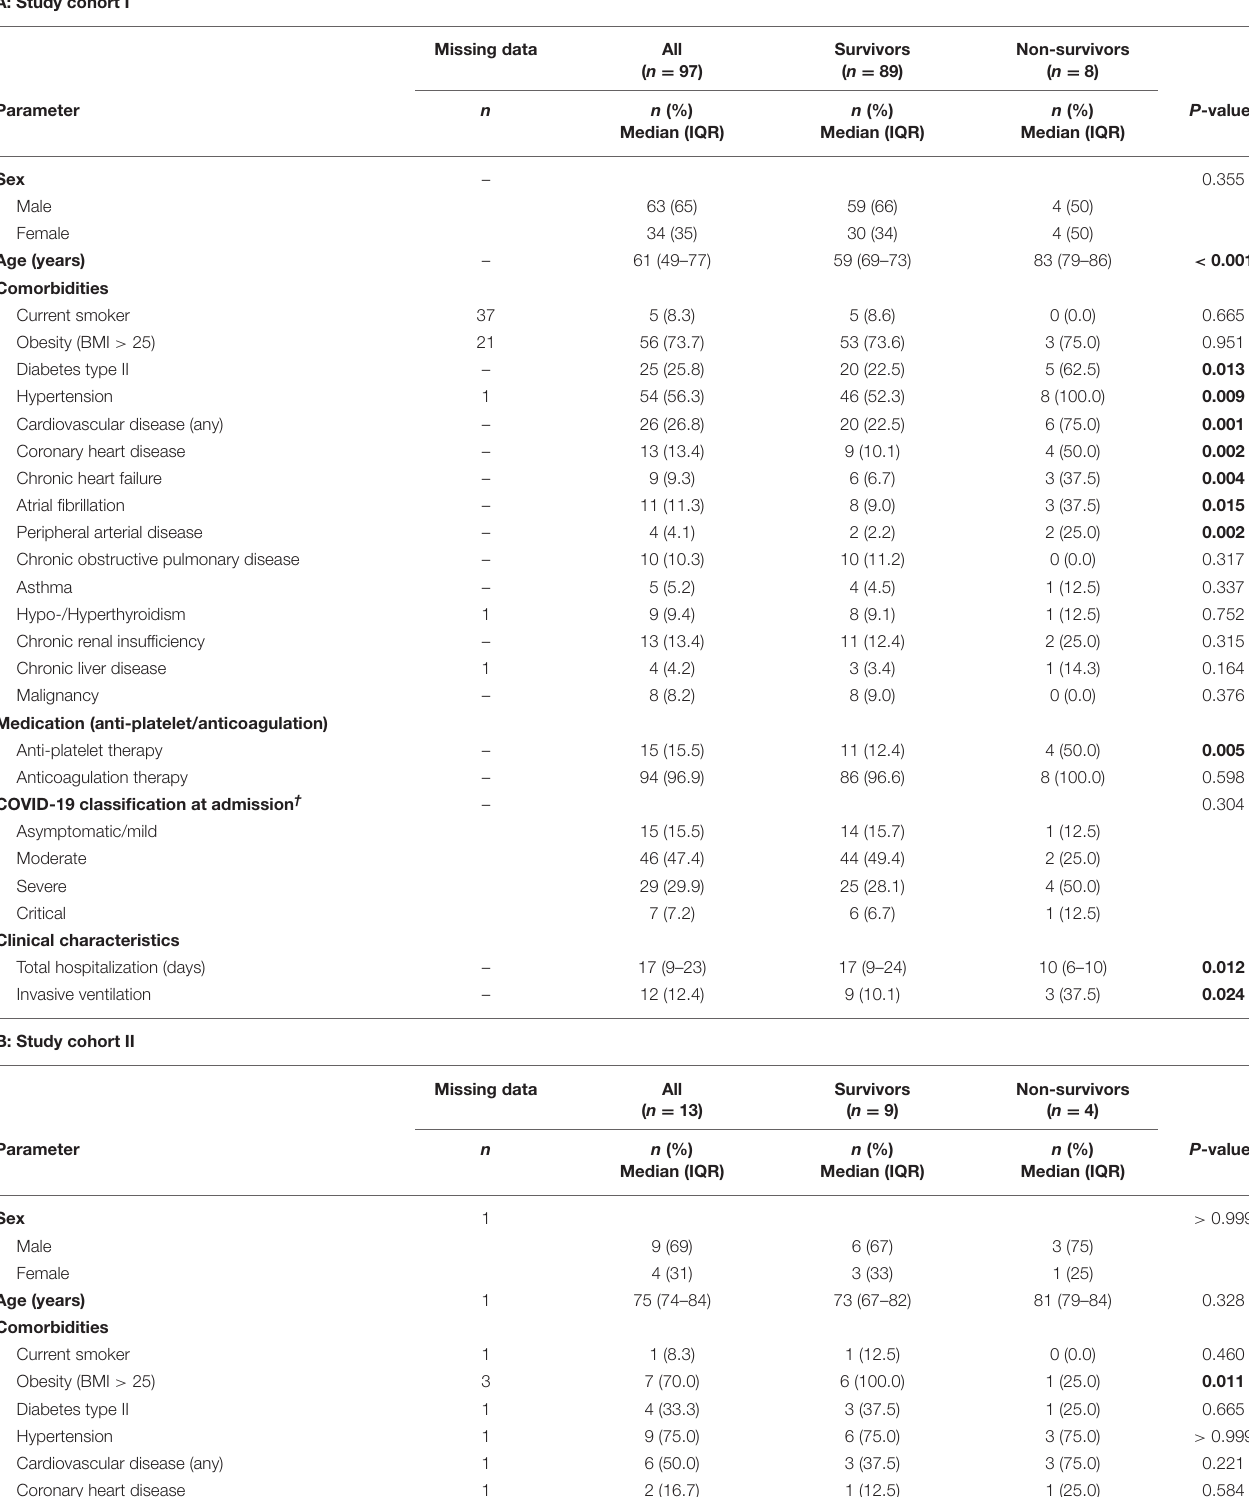
TABLE 1 | Patient demographics flow cytometric study cohort I (A) and proteomics study cohort II (B)